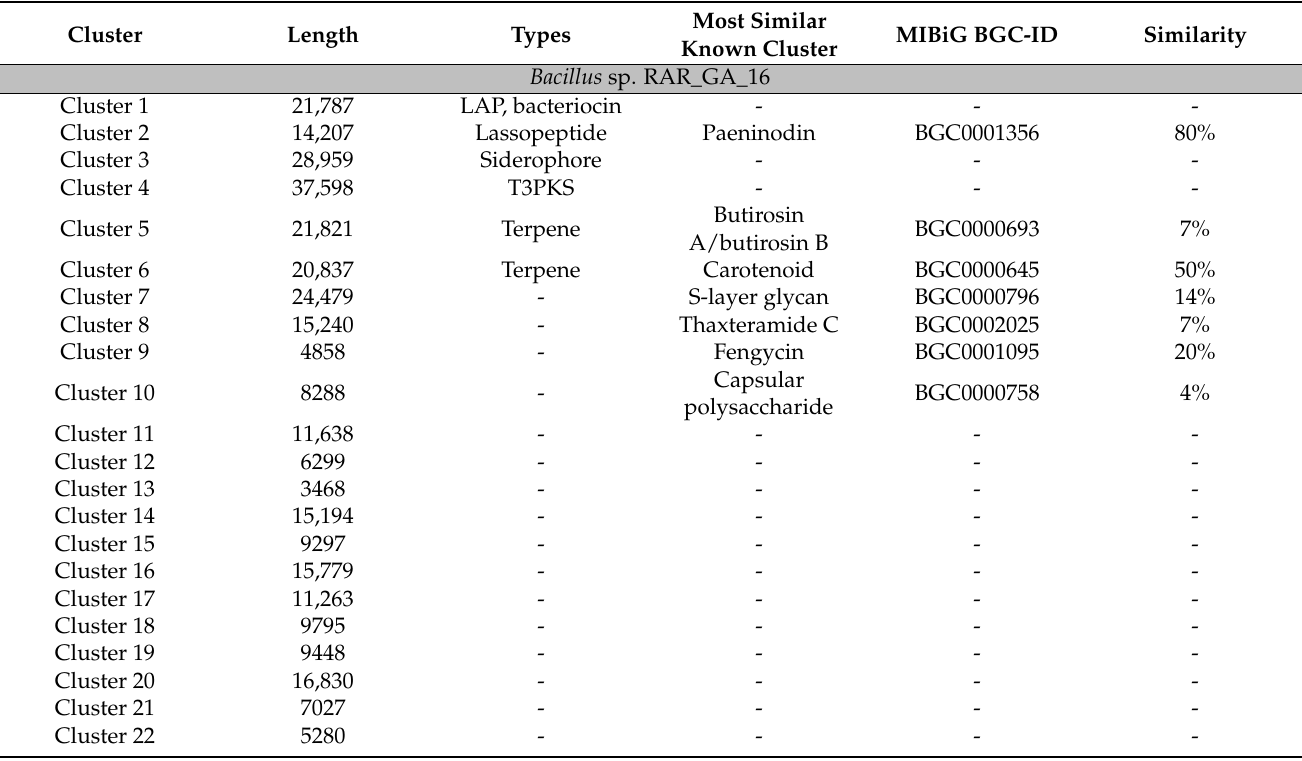
Table 8. Predicted biosynthesis gene clusters of secondary metabolites from the bacterial genomes.